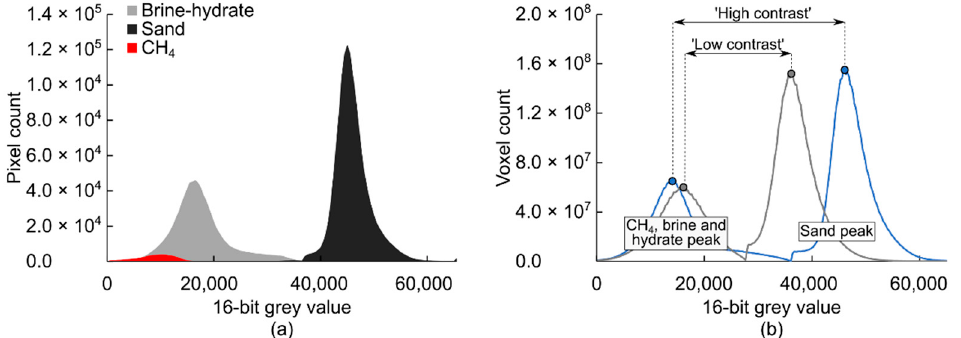
Figure 1. Grey value histograms of reconstructed and post-processed SXCT images: ( a ) of XY slice 1050 of an intermediate contrast scan, showing the frequency distribution of pixels for each material; ( b ) of two whole 3D images showing the grey value difference between histogram peaks as a measure of image contrast.